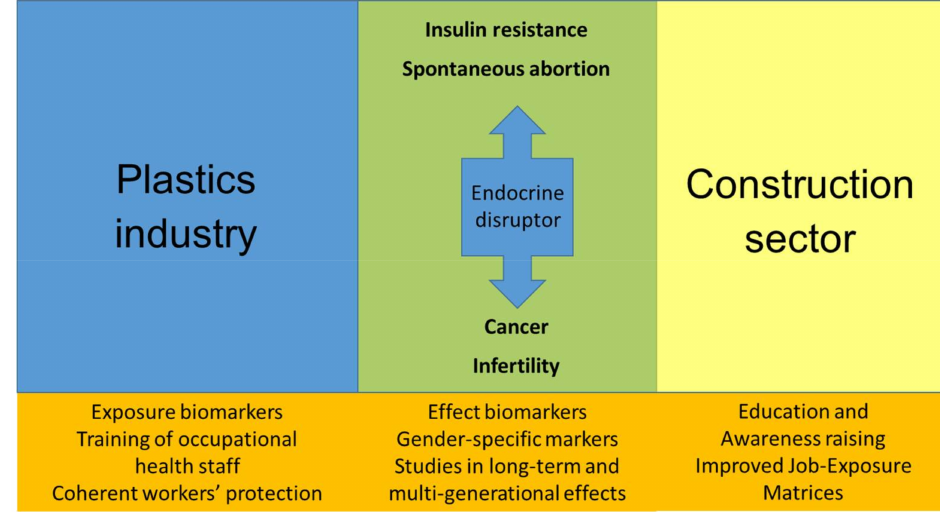
Figure 1. Schematic presentation of the topics and avenues for further